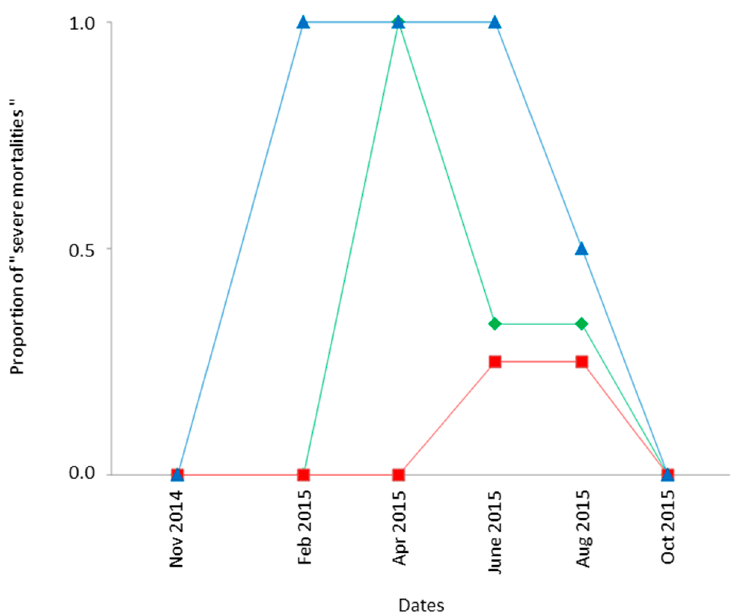
Figure 3. Spatiotemporal distribution of “severe mortality” of pre-imaginal Drosophila suzukii (Ds). The term “high mortality” refers to cases where the number of Ds from closed traps exposed in the field (Method 3; “Frozen Fruits” method) represents less than 10% of their number in the corresponding laboratory controls. Based on the analysis of deviance, data from the two “locations” within each “habitat” were pooled. Green diamonds, red squares, and blue triangles, respectively, represent the “low elevation—cultivated” (BAR and STJ), “low elevation—natural habitat” (BIO and TIG), and “mountainous backlands” (CIP and FER) areas (see also Table 1).